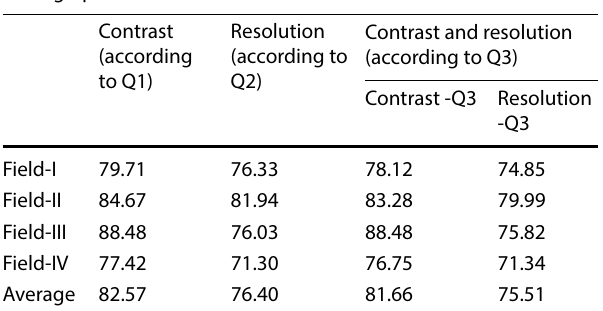
Table 6 % Match for contrast and